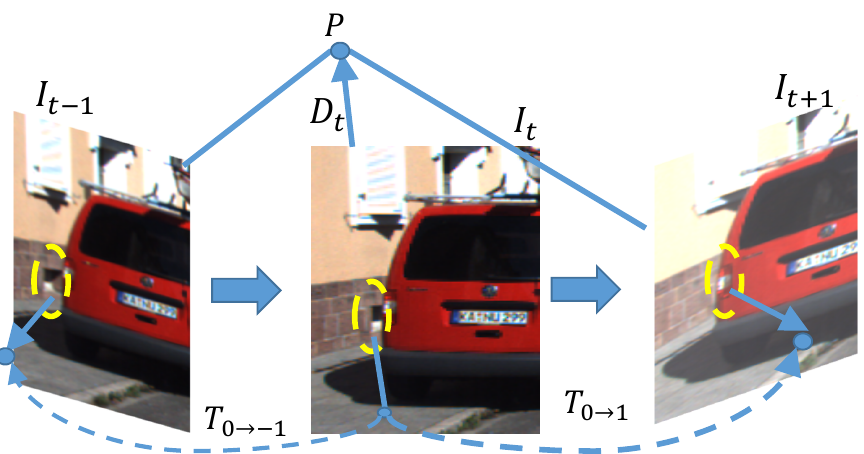
Figure 2. Example of